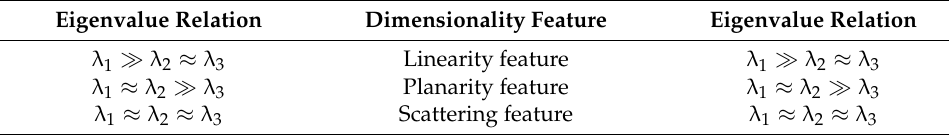
Table 1. Dimensional features judgment of local neighborhood of point cloud. Eigenvalue Relation Dimensionality